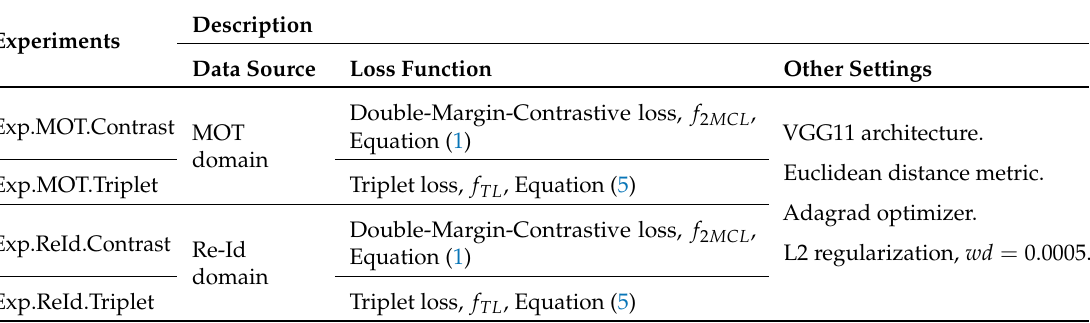
Table 2. Experiments